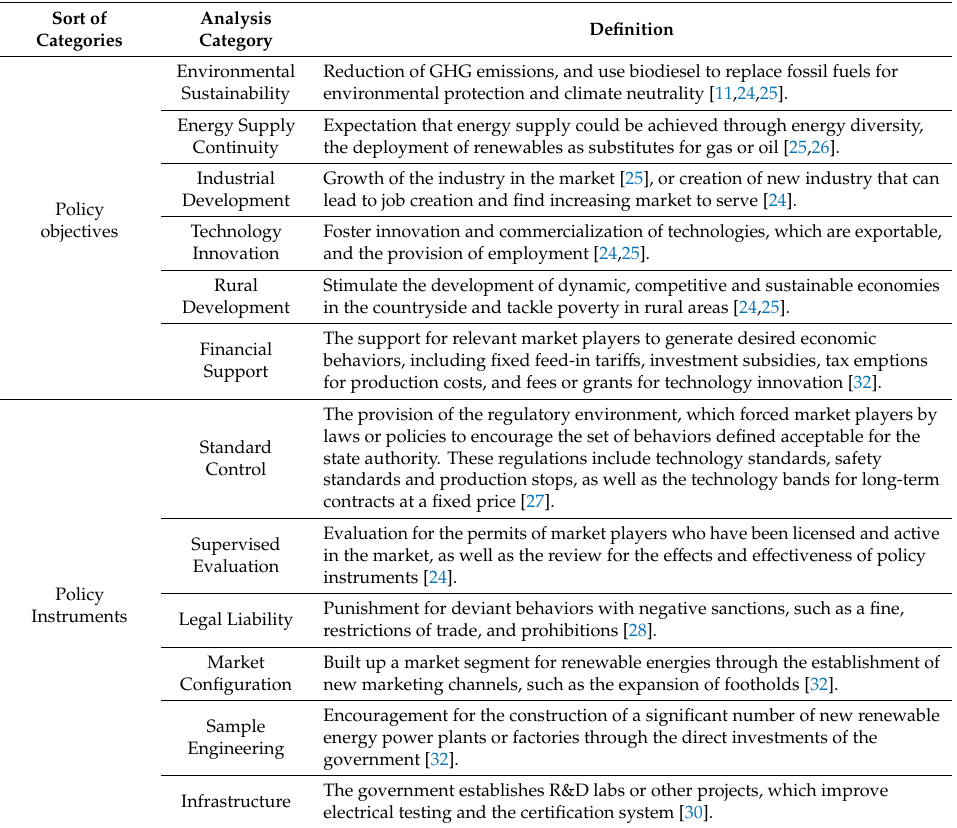
Table 2. Definitions of analysis